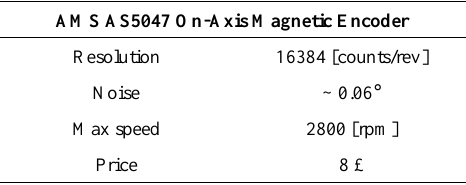
Table 3. The main encoder’s characteristics